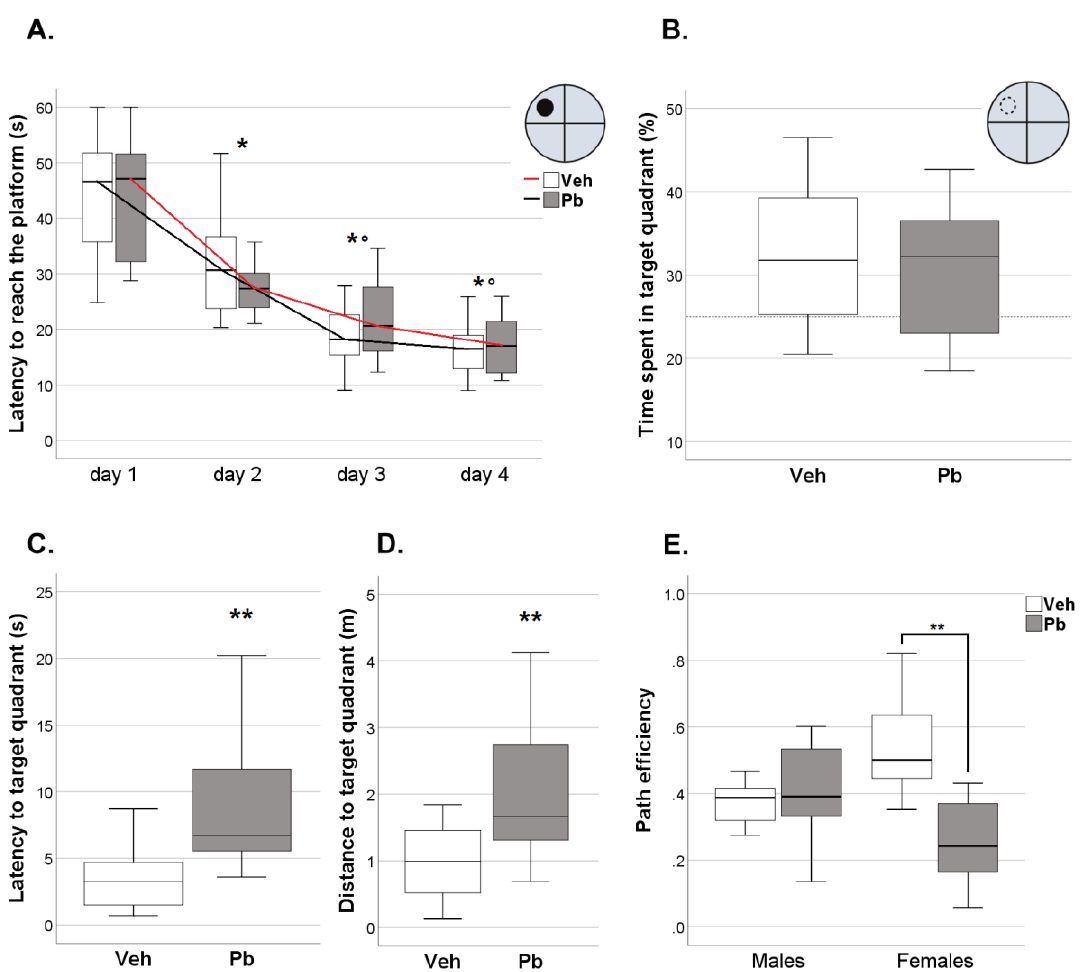
Figure 6. Effects of Developmental Pb Exposure on Spatial Memory Assessed in a Morris Water Maze (MWM). ( A ) Spatial learning across four days of training, * p < 0.05 vs. day 1, ° p < 0.05 vs. day 2; ( B ) Percentage of time spent in the target quadrant; parameters affected in Pb rats of both sexes during Probe trial, namely ( C ) Latency to reach the target quadrant and ( D ) Distance moved to reach the target quadrant; ( E ) Path efficiency in Probe trial selectively impaired in Pb female rats, ** p < 0.01. Data are sex-pooled represented, except for (E); n = 16 (7 females and 9 males)/group.